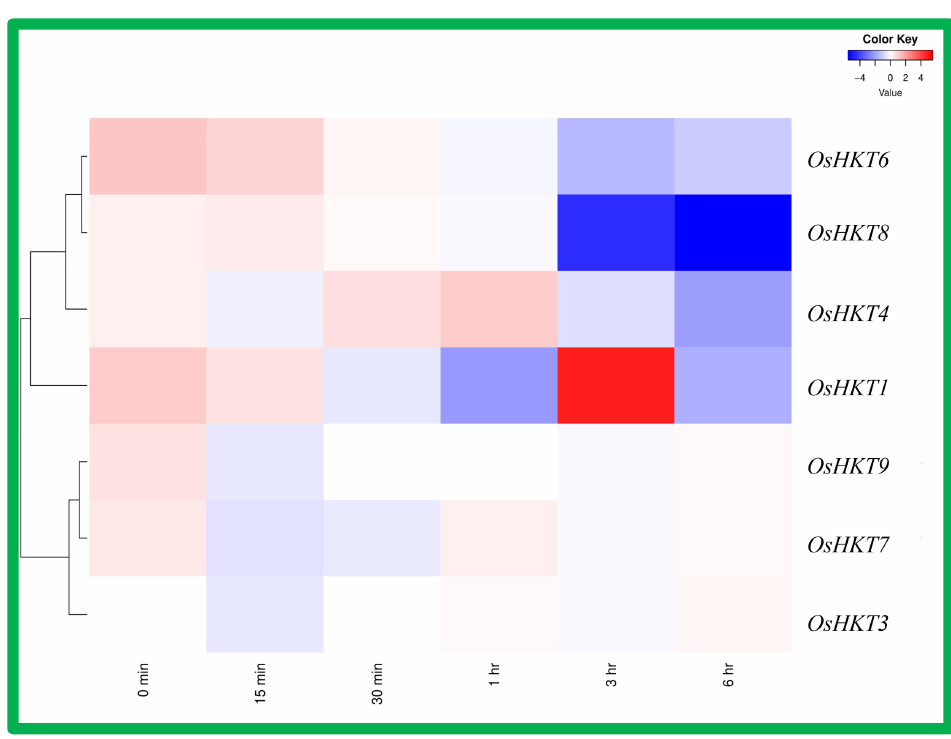
Figure 8. Expression analysis of the OsHKT gene family in rice roots under brassinosteroids application. Rows represent OsHKT members, and columns show different time points. The expression level of OsHKT [log2 (FPKM + 1)] is shown by the intensity of color: red represents high expression, and blue represents low expression.